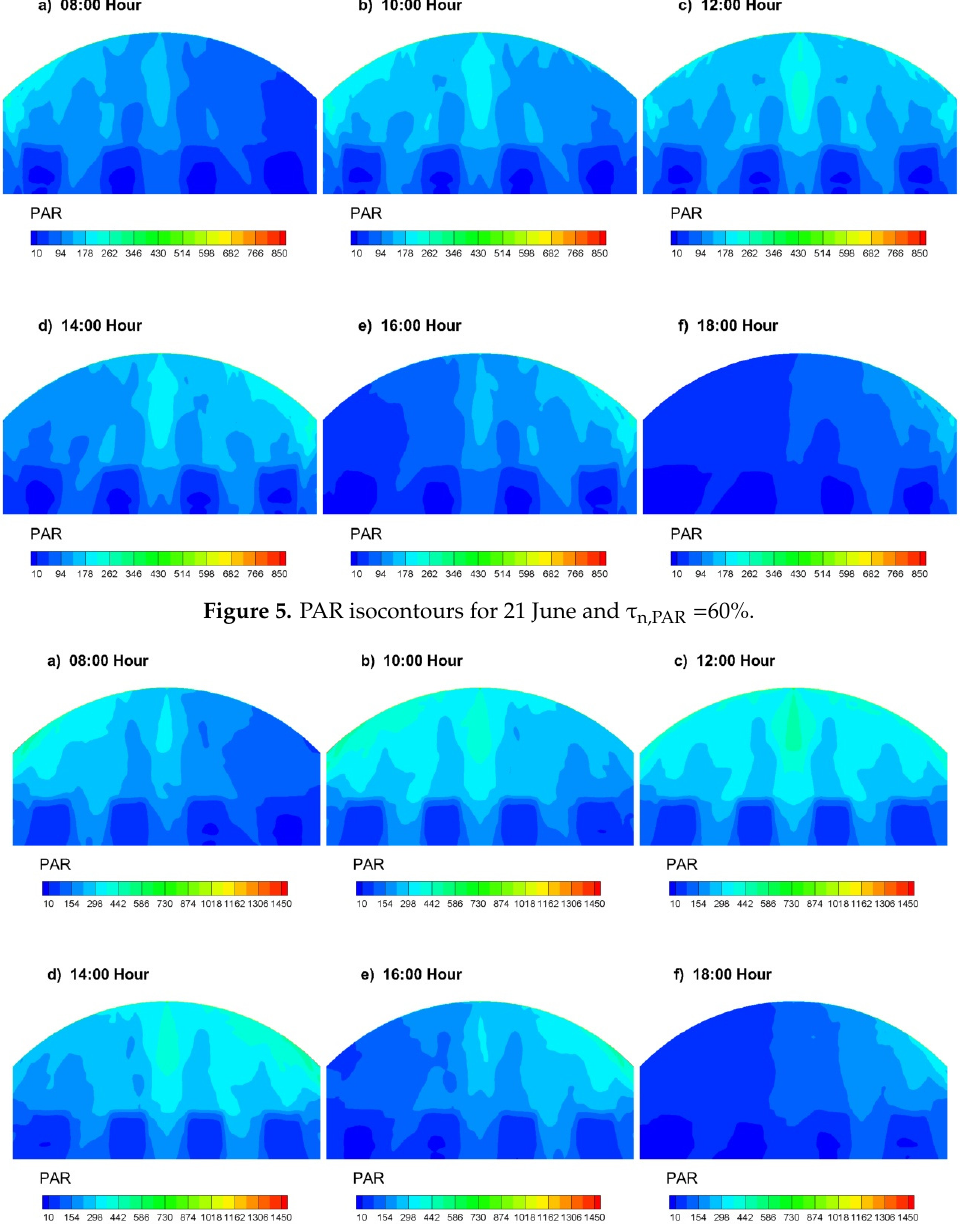
Figure 6. PAR isocontours for 21 June and τ n,PAR = 89%—bare PE cover without OPV.